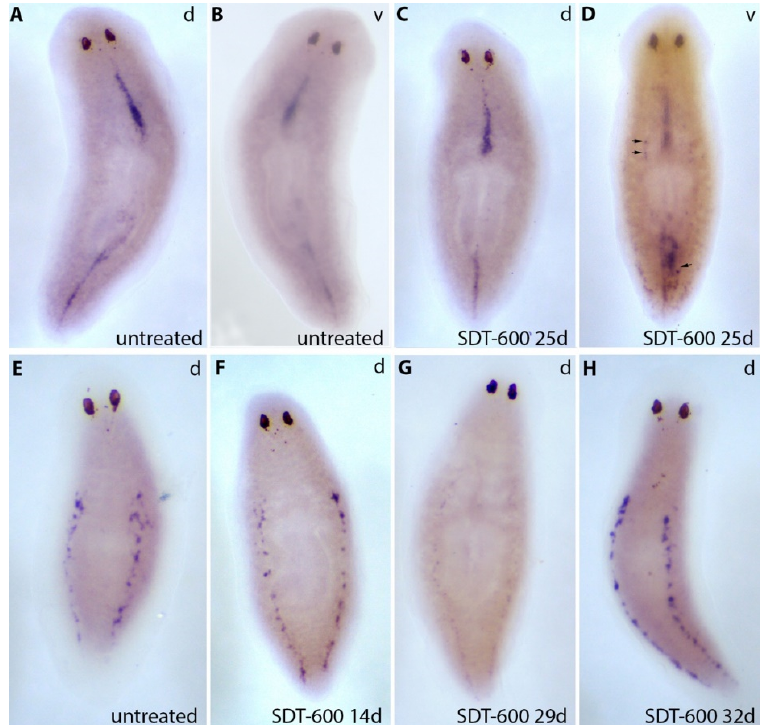
Figure 3. Djpiwi-1 and Djnos expression visualized by whole-mount in situ hybridization in intact SDT-600 animals and untreated controls. ( A , B ) Representative images of a control untreated animal hybridized with a Djpiwi-1 probe in dorsal (d) and ventral (v) views. ( C , D ) Representative images of an SDT-600 animal hybridized with a Djpiwi-1 probe 25 days after treatment in dorsal (d) and ventral (v) views. Arrows indicate novel Djpiwi-1 -positive cells at the ventral side of the animal. ( E ) Representative image of a control untreated animal hybridized with a Djnos probe in dorsal (d) view. ( F – H ) Representative images of an SDT-600 animal hybridized with a Djnos probe 14, 29, and 32 days after treatment. Scale bar corresponds to 500 µ